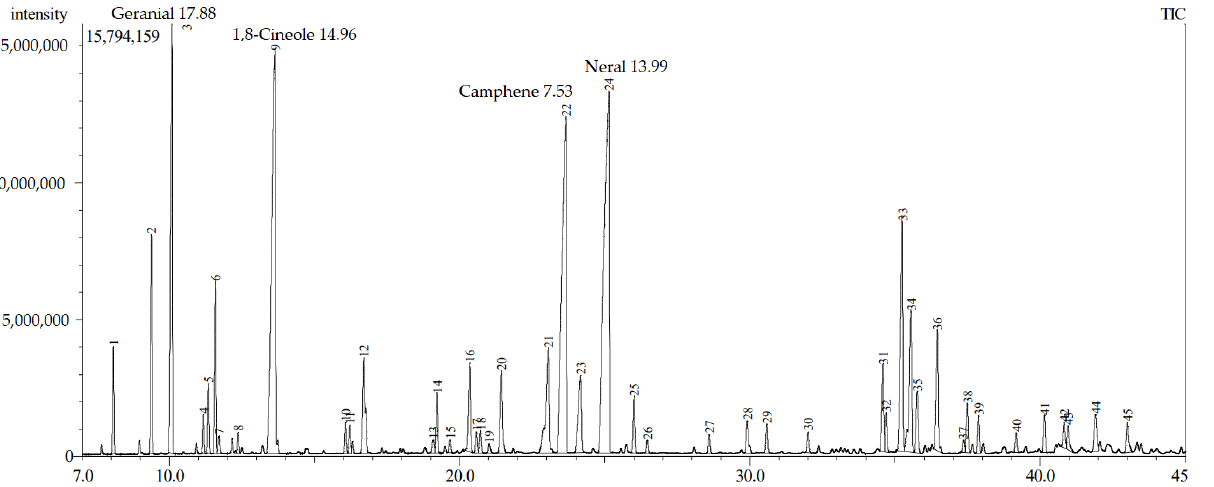
Both vibrational spectroscopy analyses of Raman and Fourier transform infrared (FTIR) spectra are displayed in Figure 2. The appearance of several peaks ranging from 400 cm − 1 to 3000 cm − 1 was attributed to the existence of multiple chemical bonds in the GEO (Figure 2a). The most important components in ginger essential oil are zingiberene, geranial, neral, and camphene [24]. At the lower frequency of the Raman spectrum (700– 900 cm − 1 ), the COC and CCO bands were detected. The CH-stretching band was at 1438 cm − 1 . Other appearance peaks for benzene rings were recorded at the middle range fre- quency: 1590 and 1602 cm − 1 of the Raman spectrum. The C=C band was at 1642 and 1684 cm − 1 , which attributed to the CH 3 group bending mode. In the chemical structure of gera- nial and neral, the double bond is conjugated with the aldehyde group. CH-bending mode was also detected at 2800–2841 cm − 1 . The Fourier Transform Infra-Red spectrum was rec- orded from 550–4000 cm − 1 , as displayed in Figure 2b. Plenty of functional groups were detected, such as OH bonds, COC, C-C stretch, C=O stretch, and OH stretch [25]. Detailed information about the peaks, wavelength, and functional groups was tabulated in Table 2.